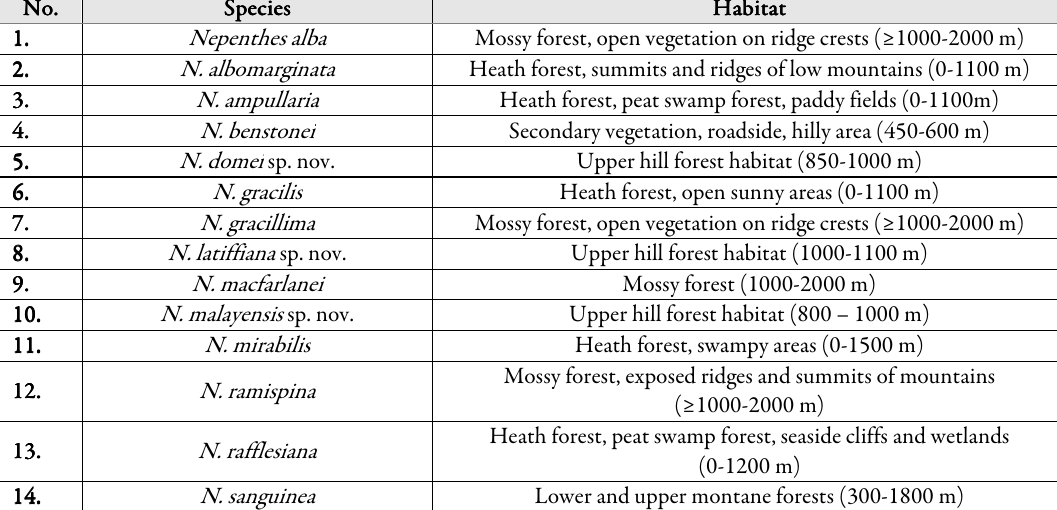
Table 1. Distribution of Peninsular Malaysia’s Nepenthes